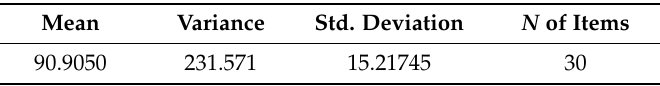
Table 5. Scale Statistics.